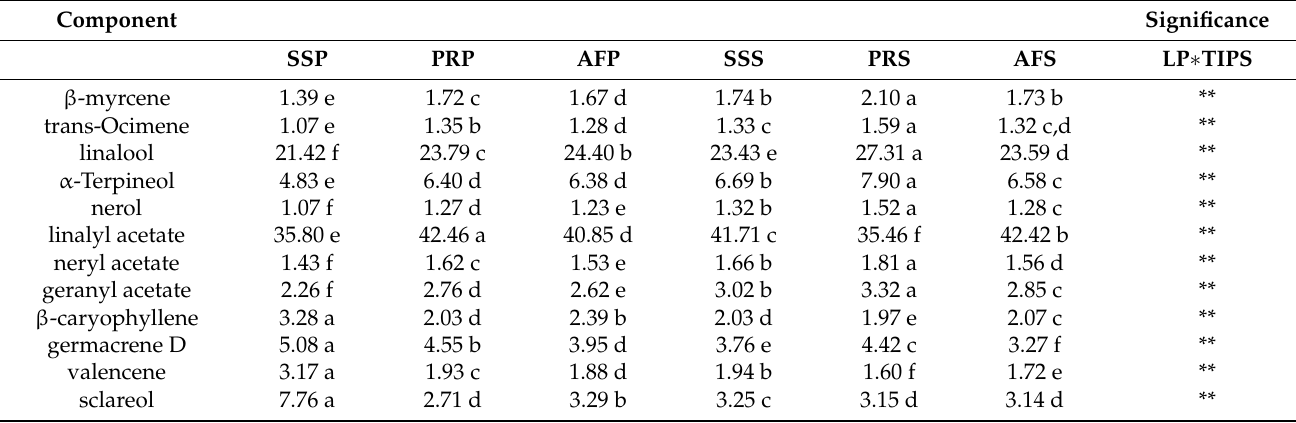
Table 7. Composition of the essential oils of the ISP and ISS of local Salvia sclarea populations—interaction of LP ∗ TIPS factors.